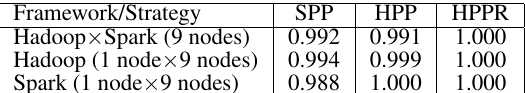
Figure 4. Segmentation of the 16K image. segmentation of the 4K image, for the three